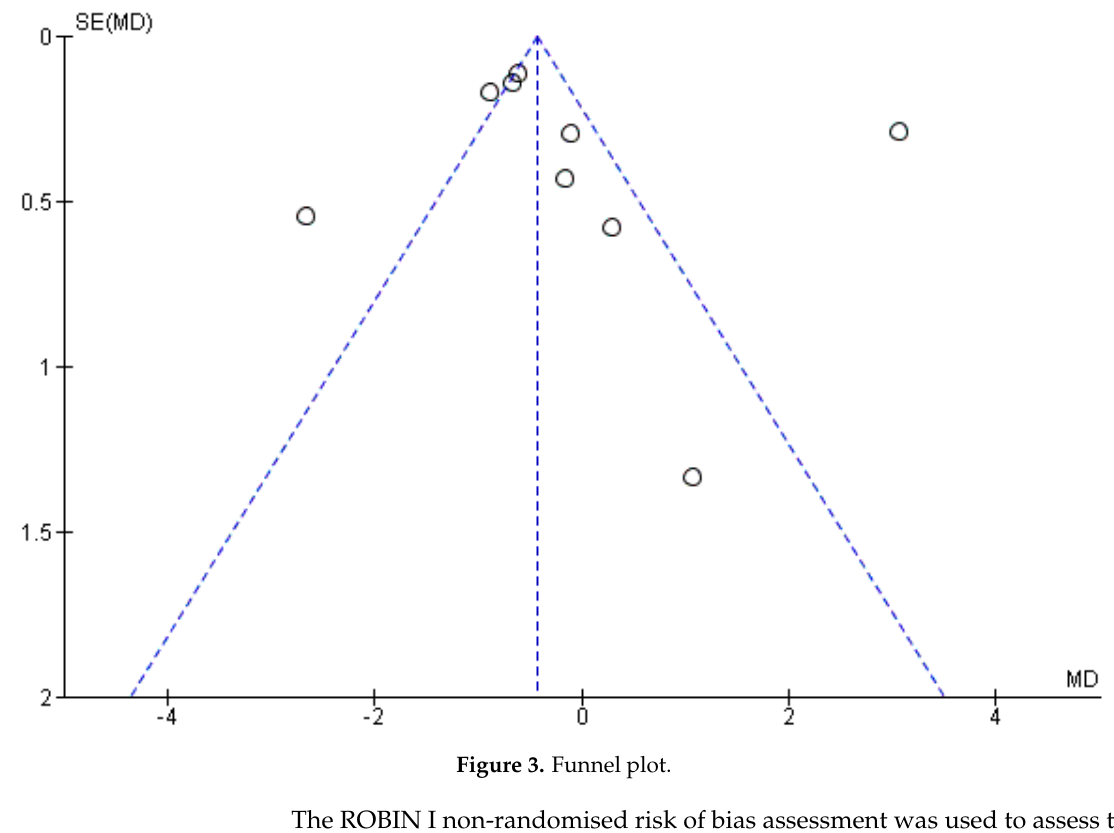
Figure 3. Funnel Figure 3. Funnel plot.